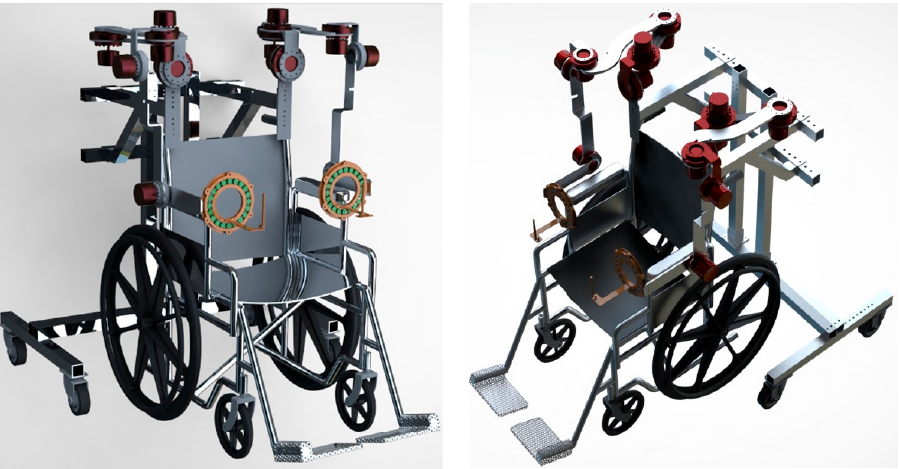
Figure 2. Virtual prototype (3D model) of the robotic exoskeleton for upper-limb rehabilitation.